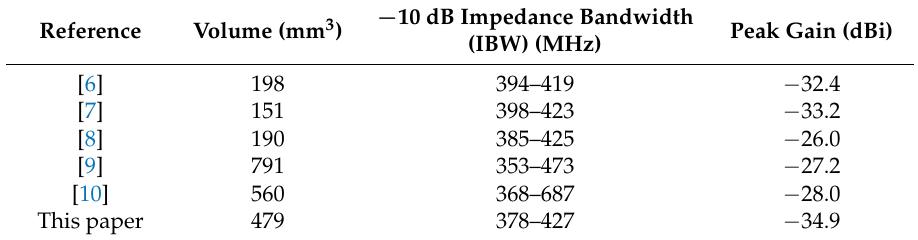
Table 1. Performance comparison of the proposed antenna and other similar implantable antennas.